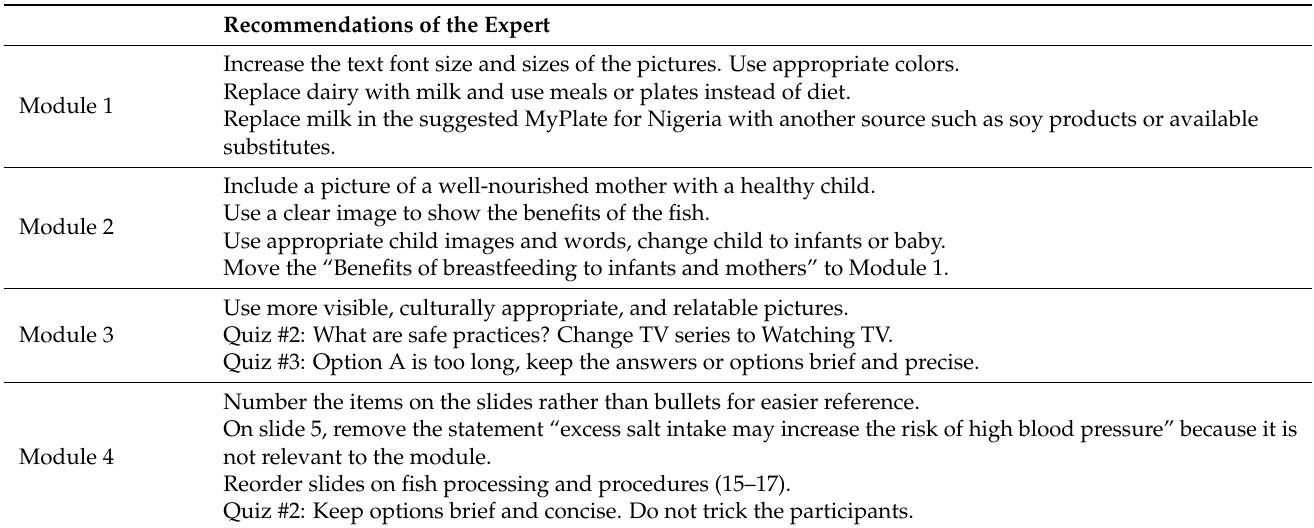
Table 3. Summary of the qualitative analysis of the experts’